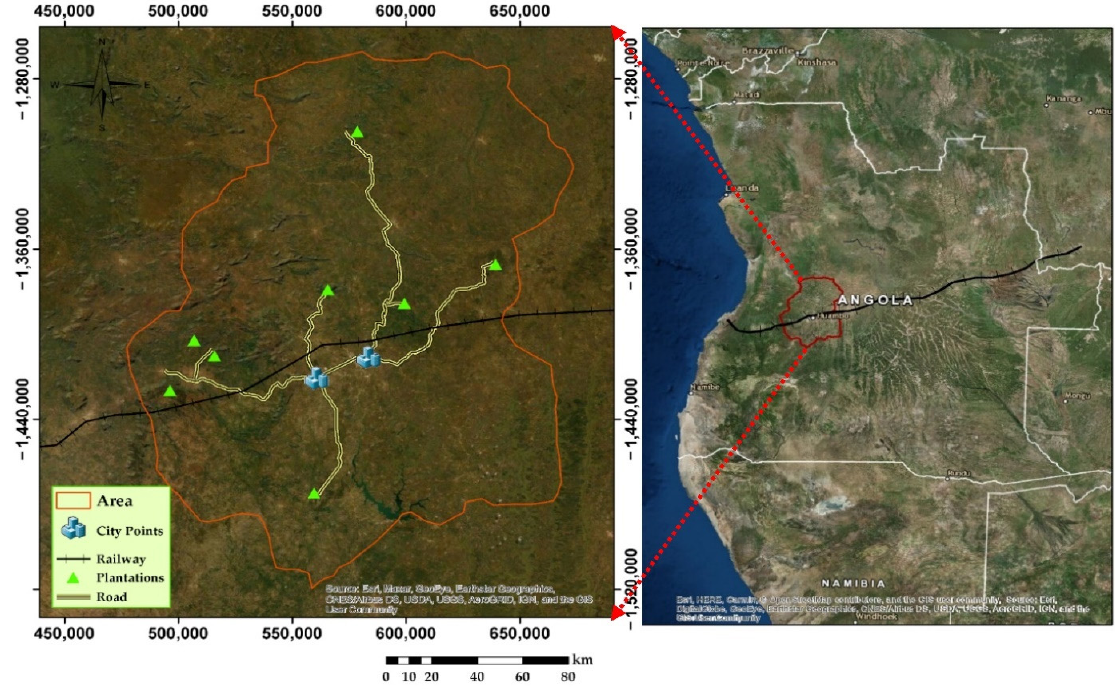
Figure 1. The geographic location of the study area in the central west part of Angola (WGS84 UTM Zone 33N).